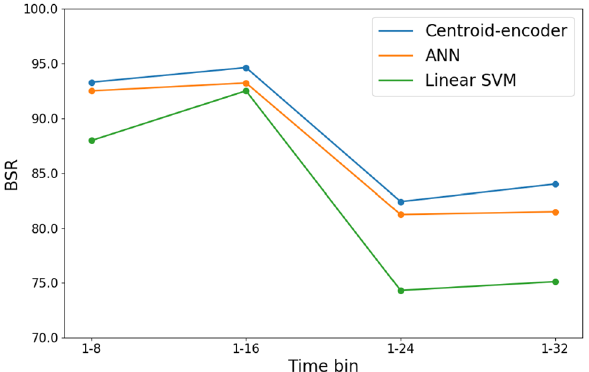
Figure 4. Balanced success rate (BSR) of LOSO testing applied on the study H3N2/DEE2 using Feature Set 3 pooled by windows. Limma normalization is applied on Study ID. There are a total of training samples 264 and 68 test